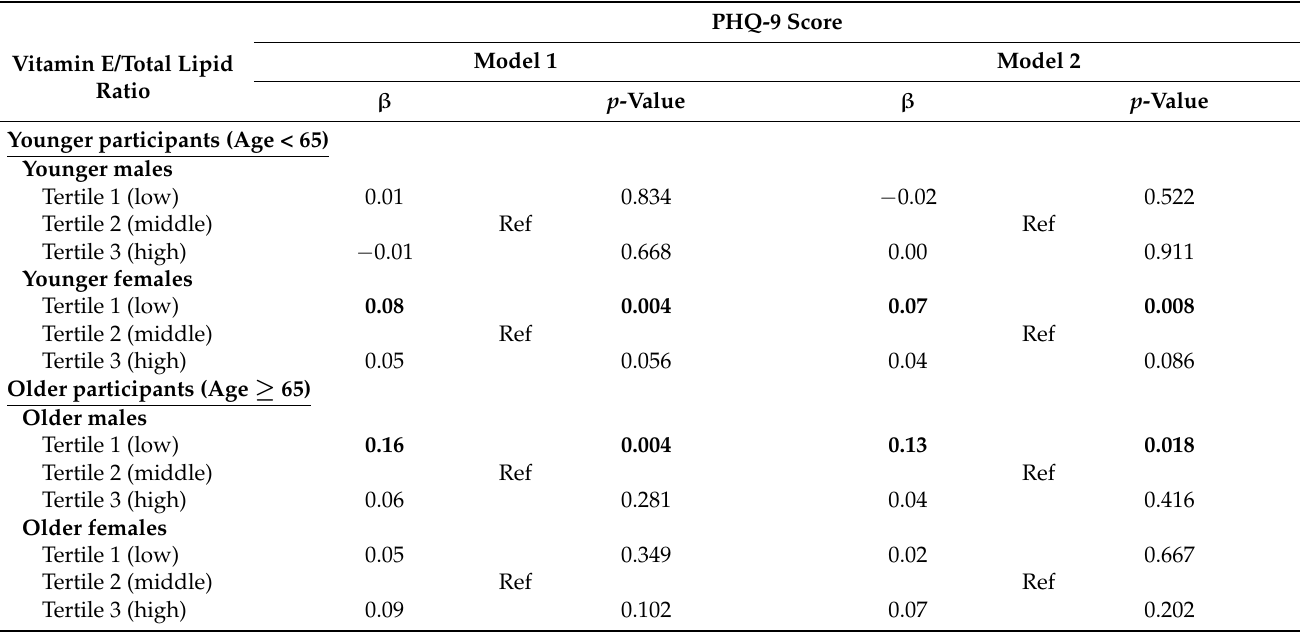
Table 2. Linear regression analysis: association between vitamin E/total lipid ratio and depressive